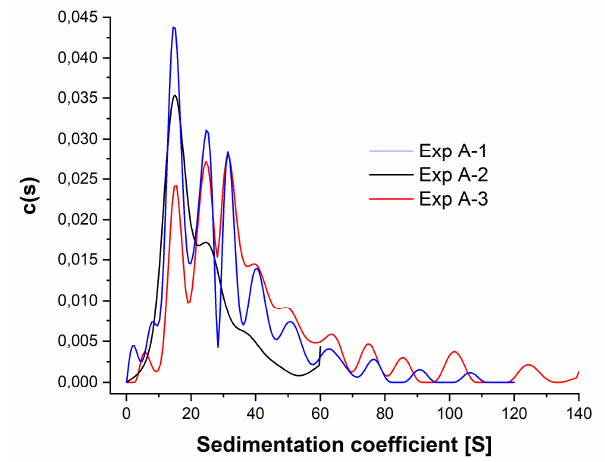
Figure 2 : Analysis using SEDFIT showing the diffusion corrected sedimentation coefficient distribution c(s) of experiment A and repetitions (A-1, A-2, A-3) at 510 nm. The diffusion corrected s- distributions show several species. [S] specifies the unit Svedberg (10 − 13